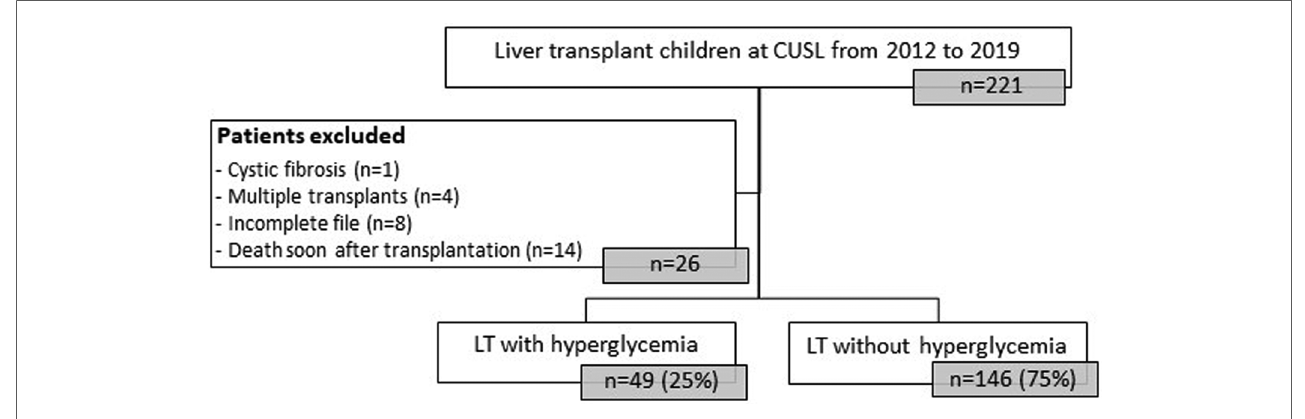
FIGURE 2 Flowchart of rDIABGRAFT pediatric LT cohort. Out of 195 pediatric patients who bene fi ted from a liver transplant in the Cliniques universitaires Saint Luc (CUSL) between April 2012 and April 2019, 25% (49/195) patients presented hyperglycemia. n: number of patients, LT: liver transplant.